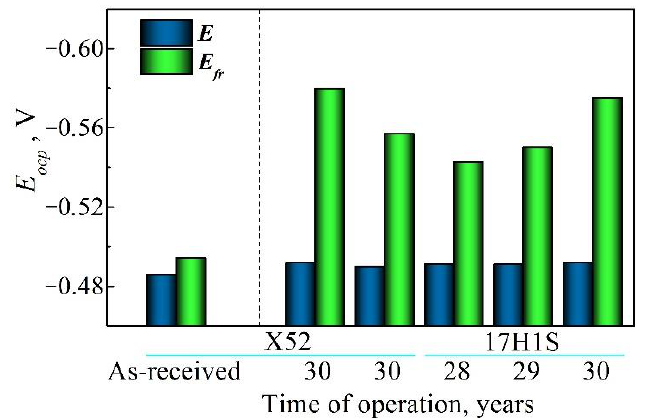
Figure 12. Open-circuit potentials E ocp of the polished surface E and the fracture surface E fr of the steel specimens made of the as-received and postoperated X52 and 17H1S steels (measured in 0.3% NaCl solution).